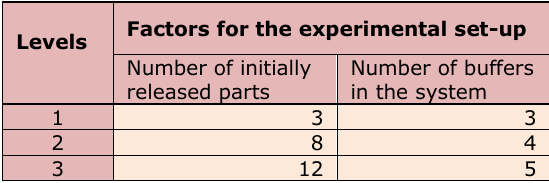
Table 1. Factor-level of The